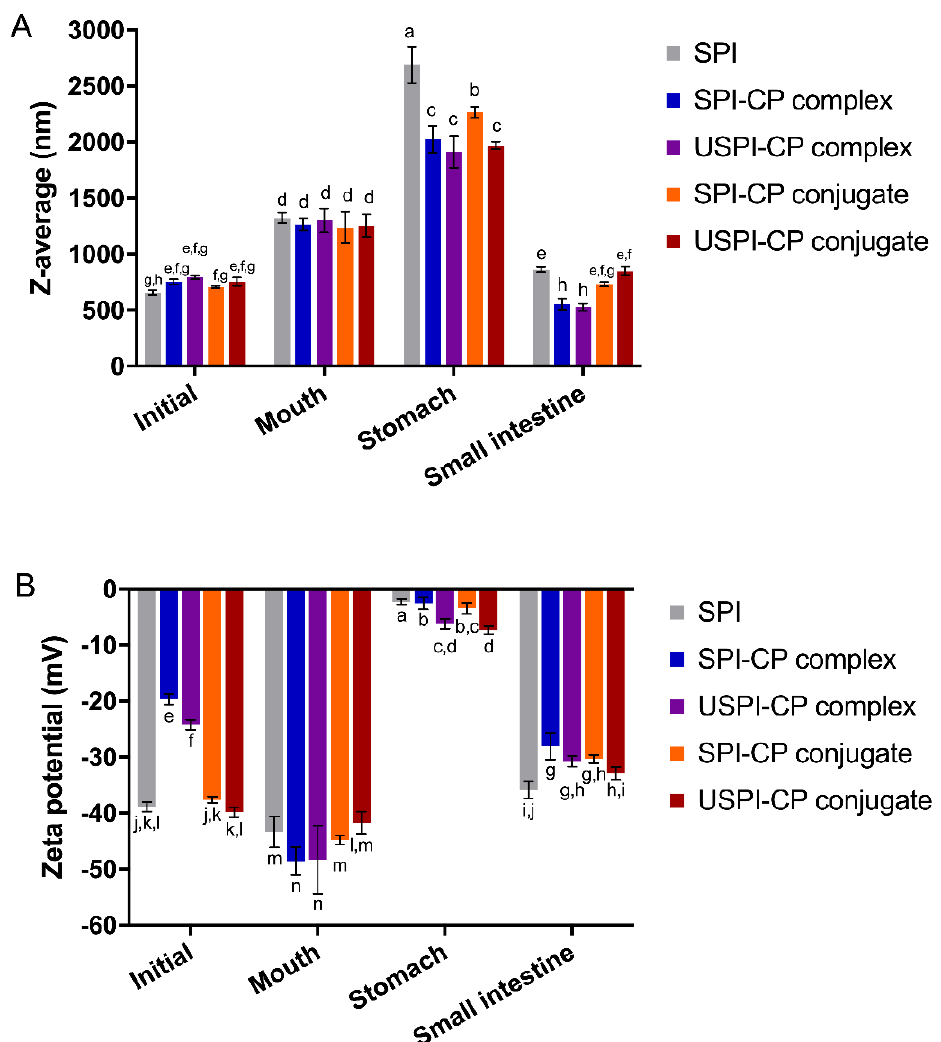
Figure 1. Changes of mean size ( A ) and zeta potential ( B ) of β -carotene nanoemulsions stabilized by different emulsifiers at different simulated in vitro digestion phases. Different letters (a–n) indicate significant differences as estimated by Duncan’s multiple range test ( p < 0.05). Samples: SPI, soy protein isolate; SPI–CP complex, electrostatic complex formed between soy protein isolate and citrus pectin; USPI–CP complex, electrostatic complex formed between soy protein isolate and citrus pectin with ultrasound treatment; SPI–CP conjugate, Maillard-type conjugate formed between soy protein isolate and citrus pectin; USPI–CP conjugate, Maillard-type conjugate formed between soy protein isolate and citrus pectin with ultrasound treatment.